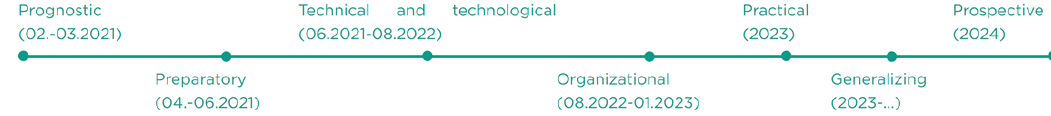
Figure 4: Stages of the Ukrainian Electronic Encyclopedia of Education